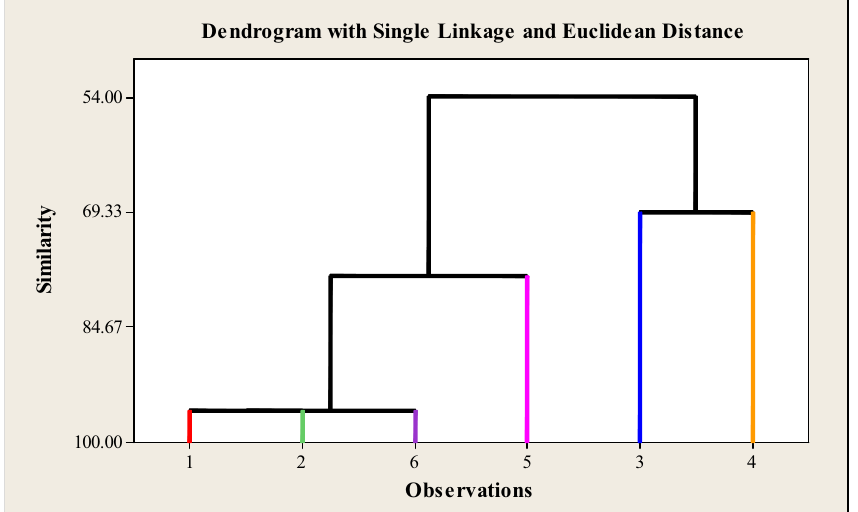
Figure 6. Similarity of geographical regions according to the presence of morbidities in individuals with SARS- CoV-2 infection registered from the State of Pará-Amazonia-Brazil, 2020. Source: OpenDataSUS, Ministry of